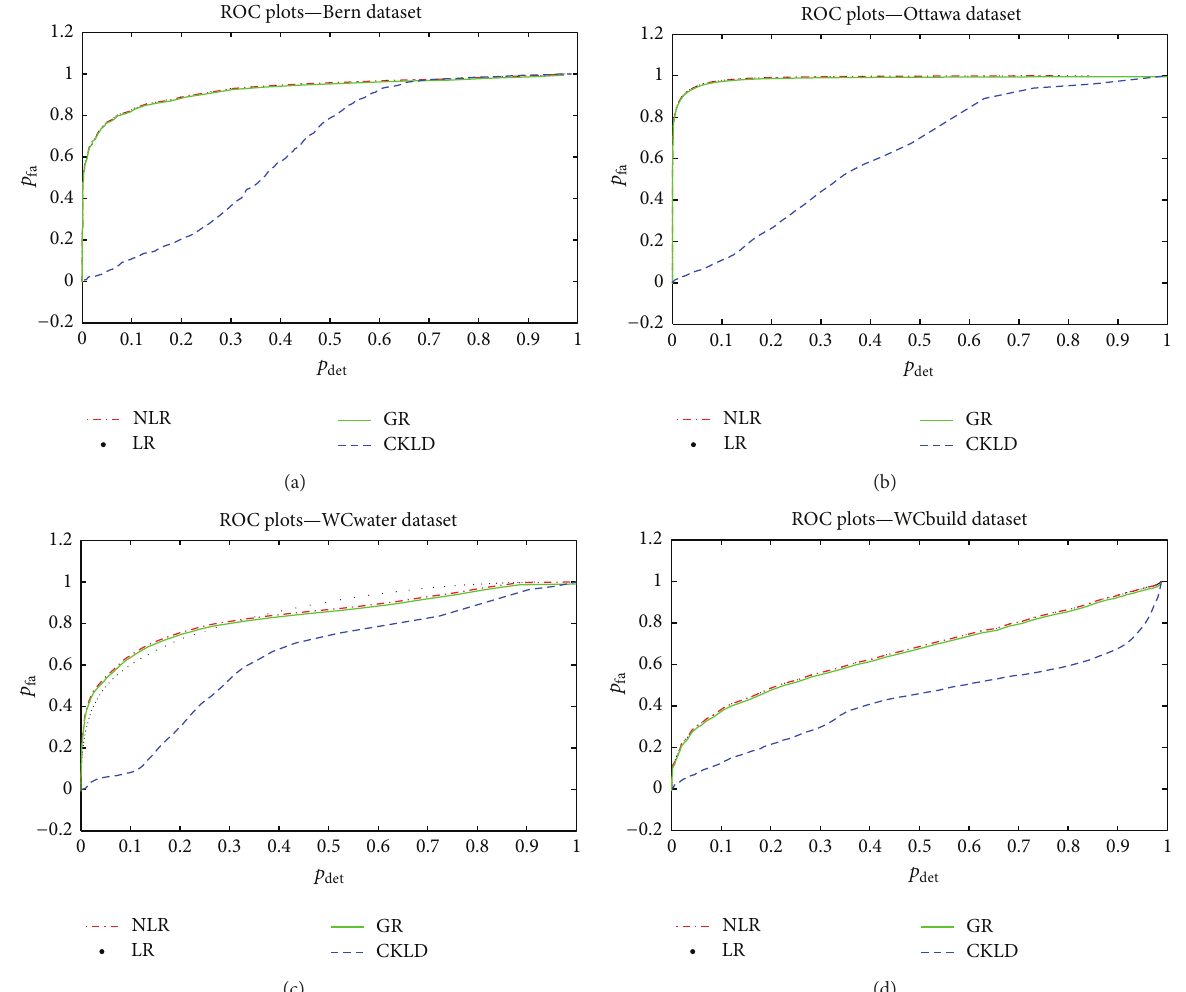
Figure 6: ROC plots comparison between NLR, LR, GLR, and CKLD. (a) Bern dataset, (b) Ottawa dataset, (c) WCwater dataset, and (d) WCbulid